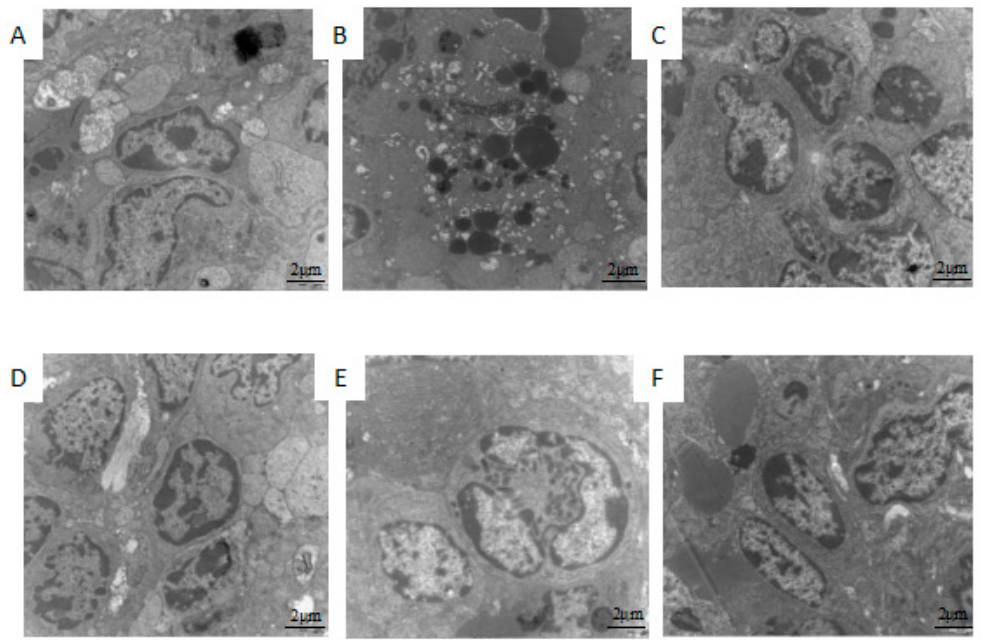
Figure 1. Effect of 5 ′ -AMP on ultra-structure morphology of mouse spleen after γ -ray irradiation (10,000 × ). ( A ) Group I: Normal group; ( B ) Group II: Model group; ( C ) Group III: Positive control (berberine hydrochloride); ( D ) Group IV: Radiation + 5 ′ -AMP (0.08 g/kgBW/day); ( E ) Group V: Radiation + 5 ′ -AMP (0.16 g/kgBW/day); and ( F ) Group VI: Radiation + 5 ′ -AMP (0.64 g/kgBW/day).